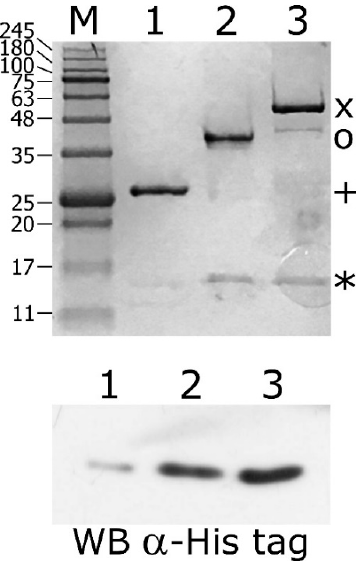
Figure 7. Glutathion S ‐ transferase (GST) ‐ pull down assay of purified His ‐ HspR incubated with GST ‐ HrcA or GST ‐ HspR bound to Glutathione ‐ Sepharose slurry. Upper panel: samples collected from the column containing GST alone (lane 1), GST ‐ HspR ‐ (lane 2) and GST ‐ HrcA ‐ GSH ‐ Sepharose slurry (lane 3) were separated by SDS ‐ PAGE together with molecular mass ladder (lane M) and stained with Coomassie Brilliant Blue. The bands corresponding to GST (+), GST ‐ HspR (o), GST ‐ HrcA (x) and His ‐ HspR (*) are indicated on the right. Lower panel: samples collected from the column containing GST alone (lane 1) and GST ‐ HrcA ‐ (lane 2) and GST ‐ HspR ‐ GSH ‐ Sepharose slurry (lane 3) were separated by SDS ‐ PAGE, blotted on a nylon membrane and stained with anti ‐ His Tag antibody.